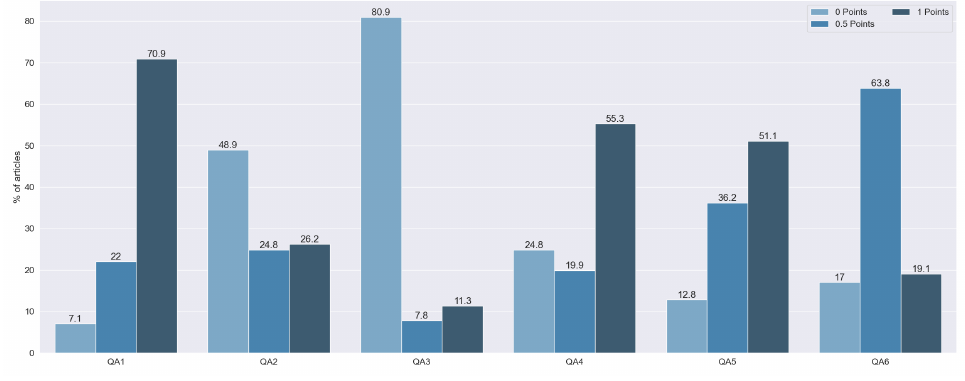
Figure 5. Total quality punctuation of each article by question. Vertical axis indicates the percentage of articles for a